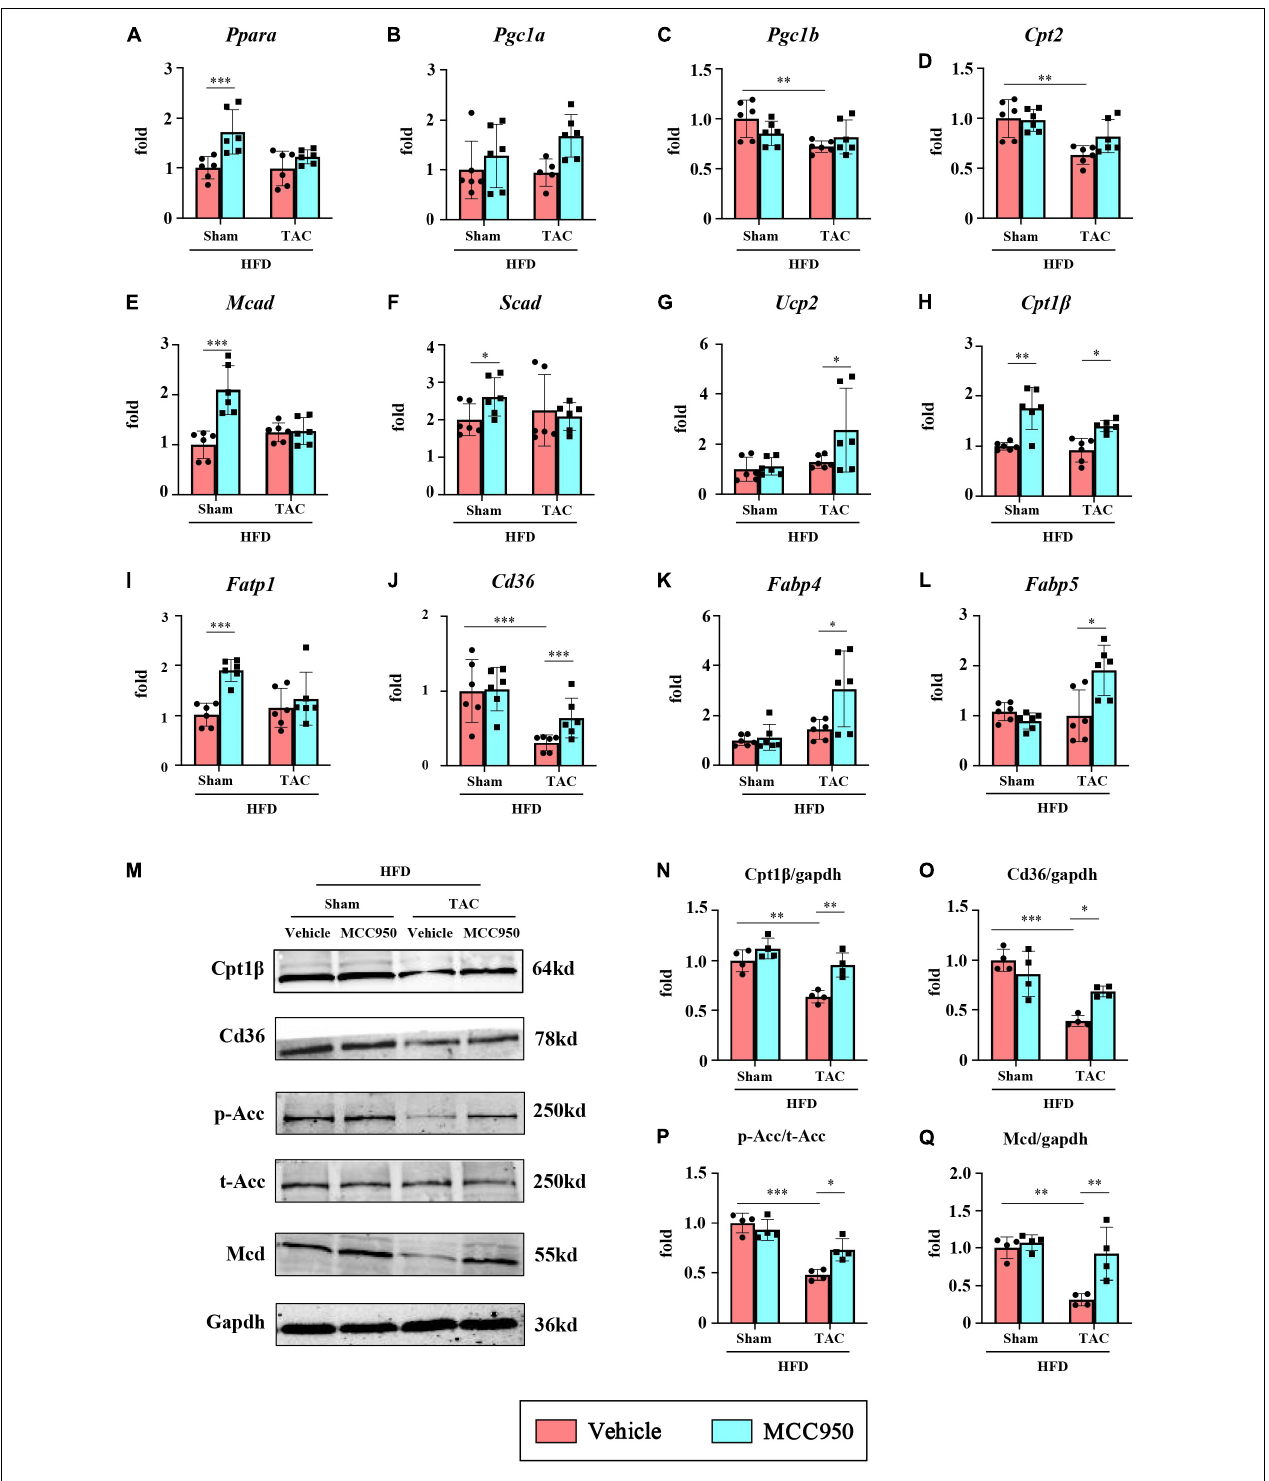
FIGURE 6 | MCC950 increased the gene expression for FA use in obese mice after TAC surgery. Relative mRNA expression of (A) PPAR α , (B) PGC1 α , (C) PGC1 β , (D) CPT2, (E) MCAD, (F) SCAD, (G) UCP2, (H) CPT1 β , (I) FATP1, (J) CD36, (K) FABP4, (L) FABP5, n = 6. (M–Q) Representative blots and quantitative analysis showing the expression levels of CPT1 β , CD36, p-ACC, t-ACC, and MCD, n = 4. PPAR, peroxisome proliferator-activated receptor; PGC1, PPAR γ -coactivator-1; CPT, carnitine palmitoyl transferase; MCAD, medium-chain acyl-CoA dehydrogenase; SCAD, short-chain acyl-CoA dehydrogenase; UCP2, uncoupling protein 2; FATP, FA transport protein; FABP, FA binding protein. ACC, acetyl-CoA carboxylase; MCD, malonyl-CoA decarboxylase. ∗ p < 0.05, ∗∗ p < 0.01, ∗∗∗ p < 0.001.